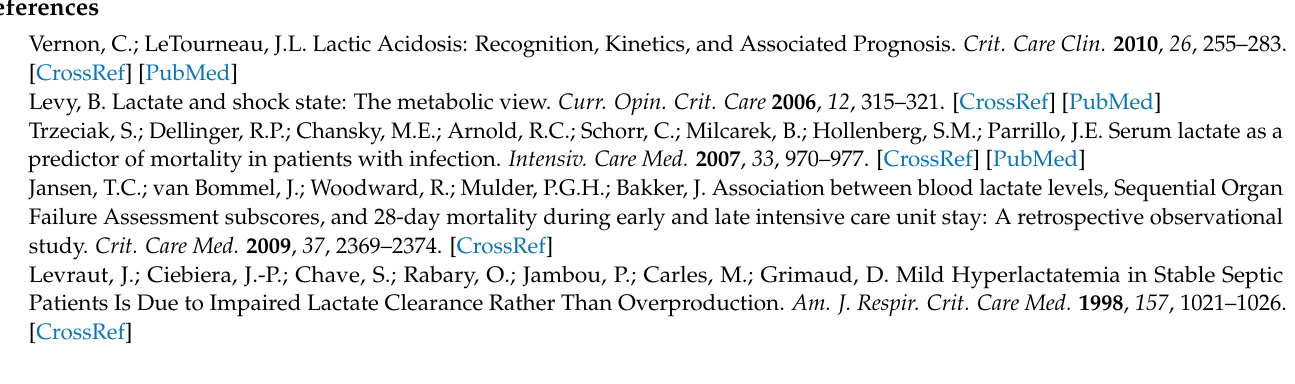
Figure S3: Error rate of RF model by number of trees; Figures S4–S10: Calibration plot of among all models; Supplementary method: detailed model development and TRIPOD